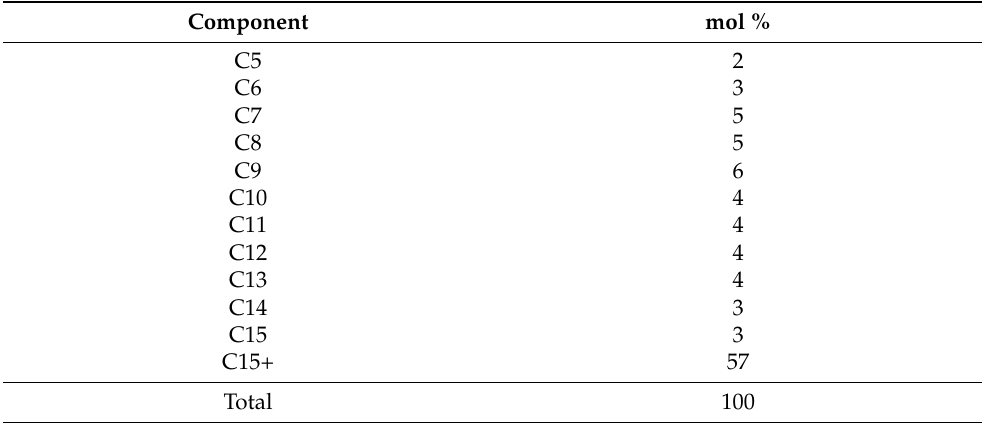
Figure 2. Cumulative particle size distribution of the glass beads. Table 1. Crude oil composition.